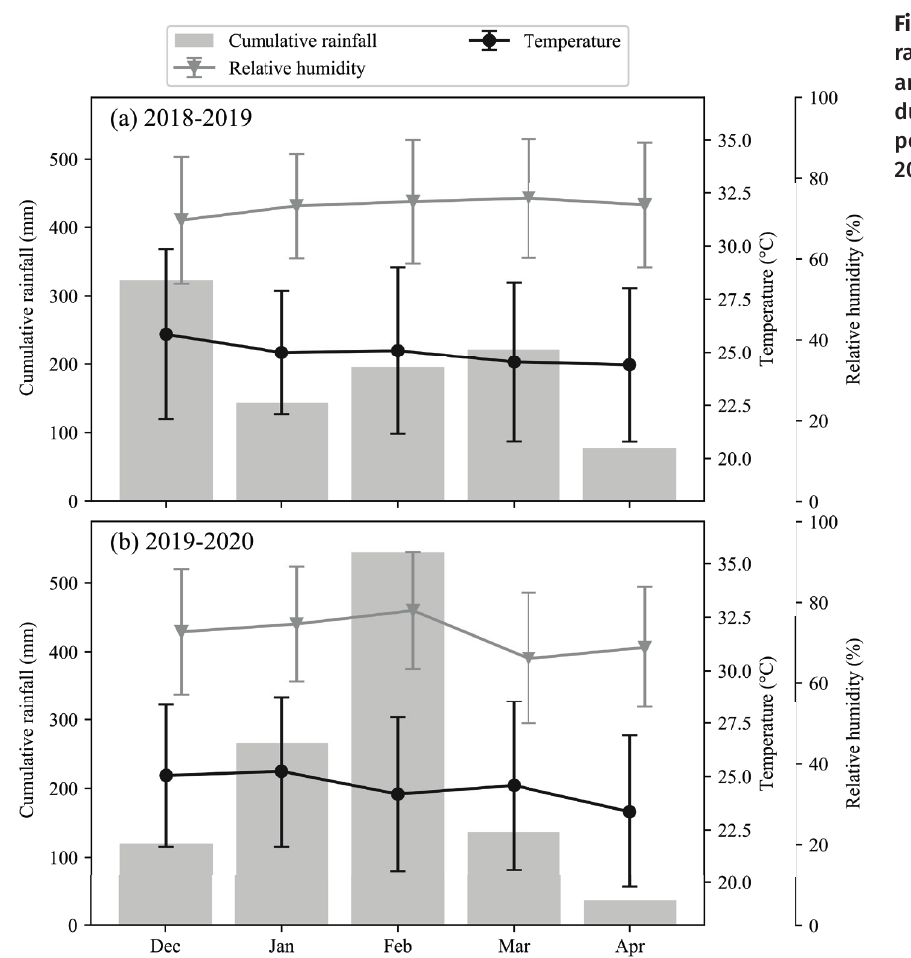
Figure 4. Cumulative rainfall, mean temperature and relative humidity during the experimental period. (a) 2018-19;